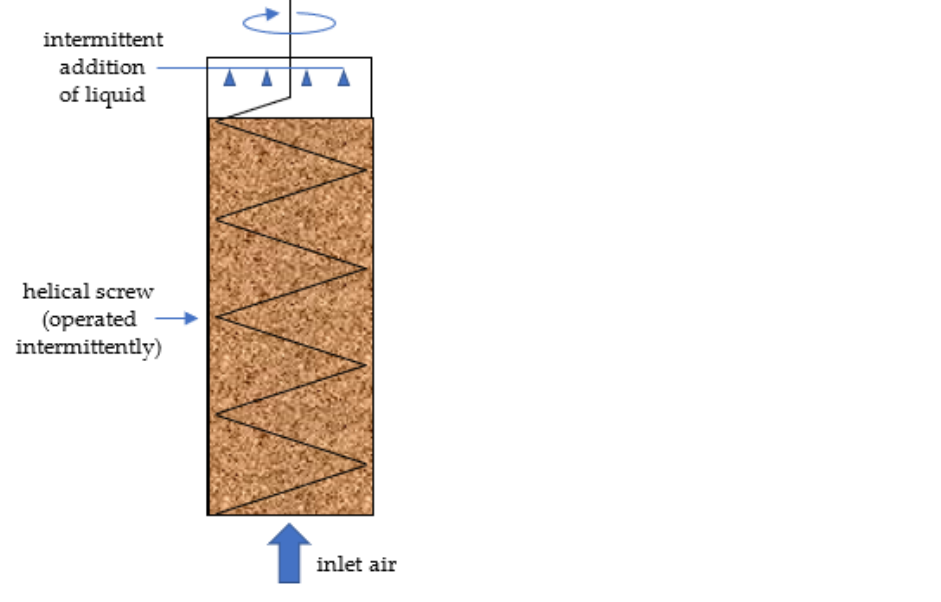
Figure 6. Principles of the design and operation of the trickle-bed reactor of Shahryari et al. [59].